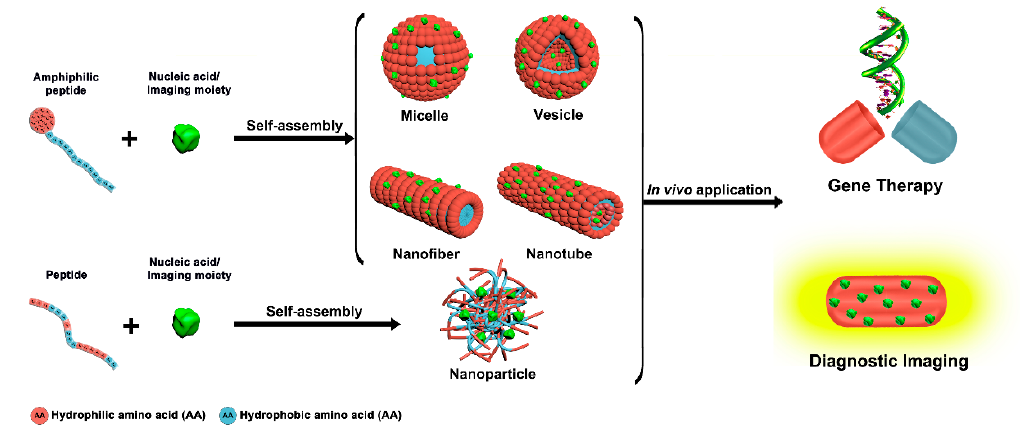
Figure 1. Peptide-based supramolecular nanoassemblies in gene therapy and diagnosis.